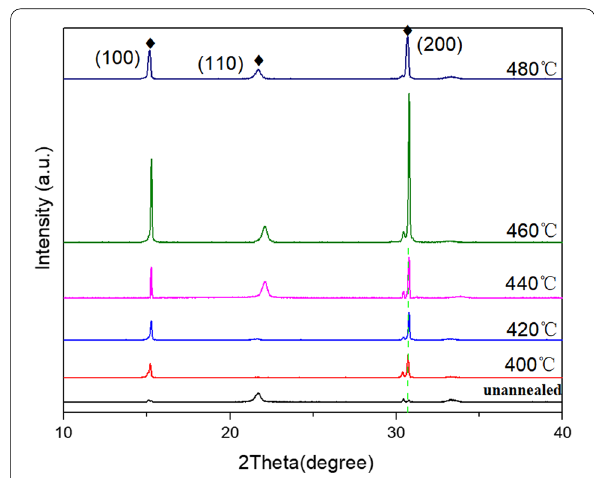
Fig. 5 XRD patterns of CsPbBr 3 thin films annealed at different